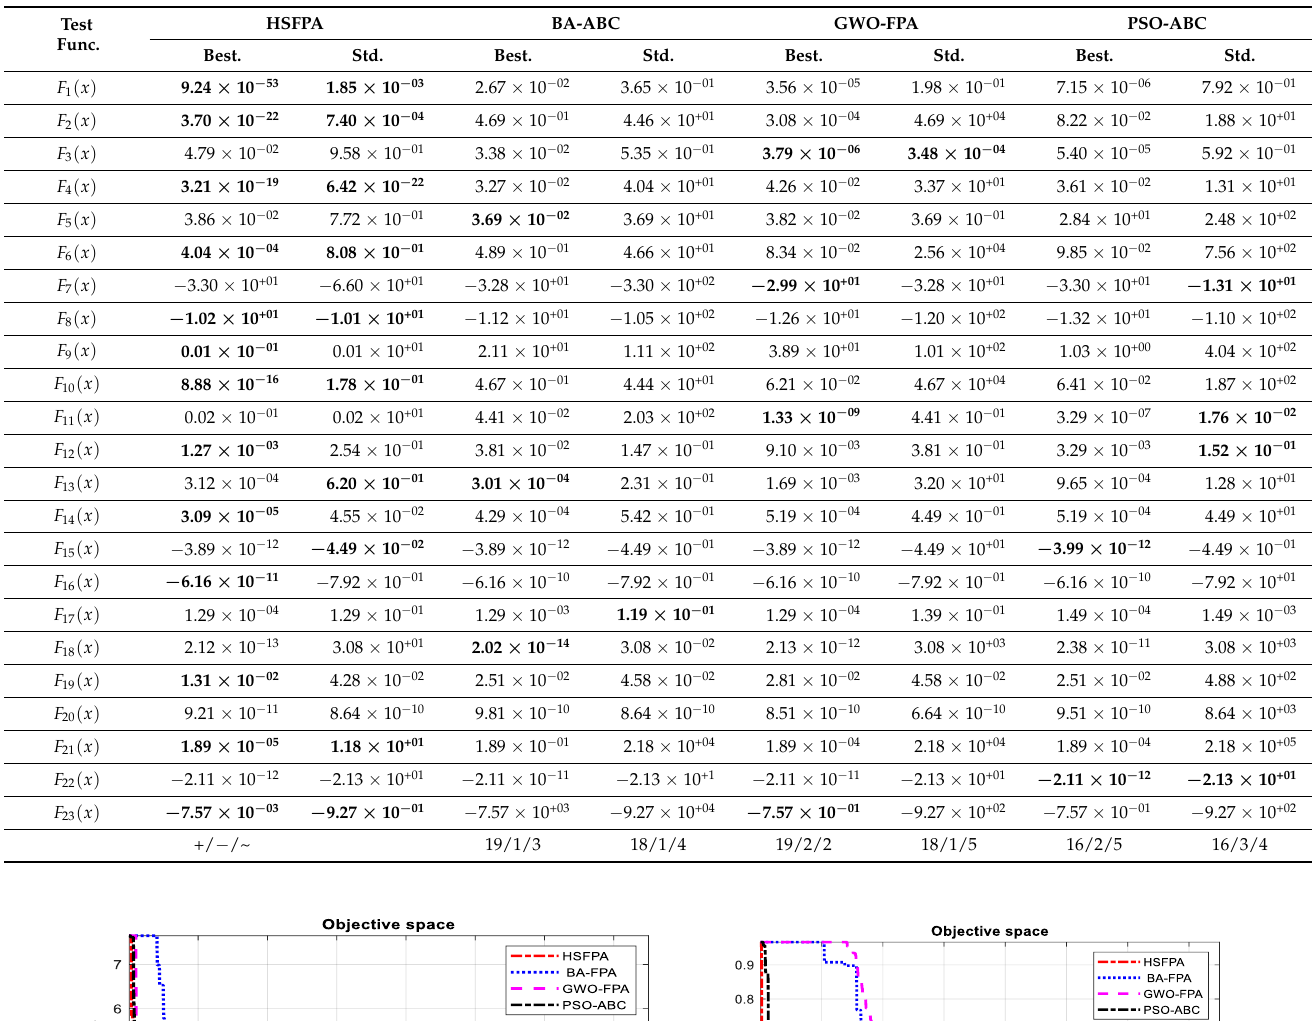
Table 4. The obtained results of the HSFPA are compared with hybrid methods, e.g., BA-ABC, PSO-ABC, and GWO-FPA algorithms, for 23 selected testing functions. HSFPA BA-ABC GWO-FPA PSO-ABC Test Func. Best. Std. Best. Std. Best.